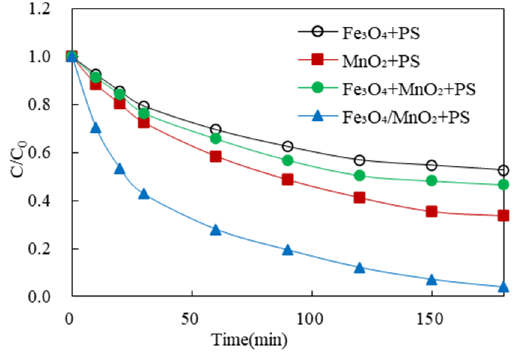
Figure 7. Degradation of 2,4-DCP in different systems.